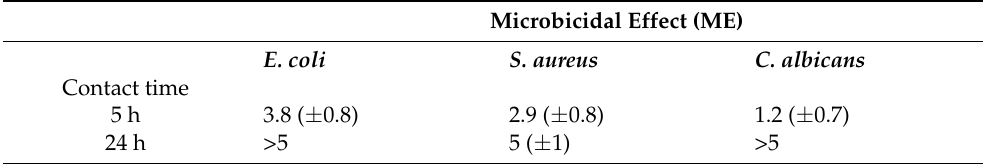
Table 3. Microbicidal effect (ME) of glass-Im-[Cu 2 (BPXD)] samples for different contact